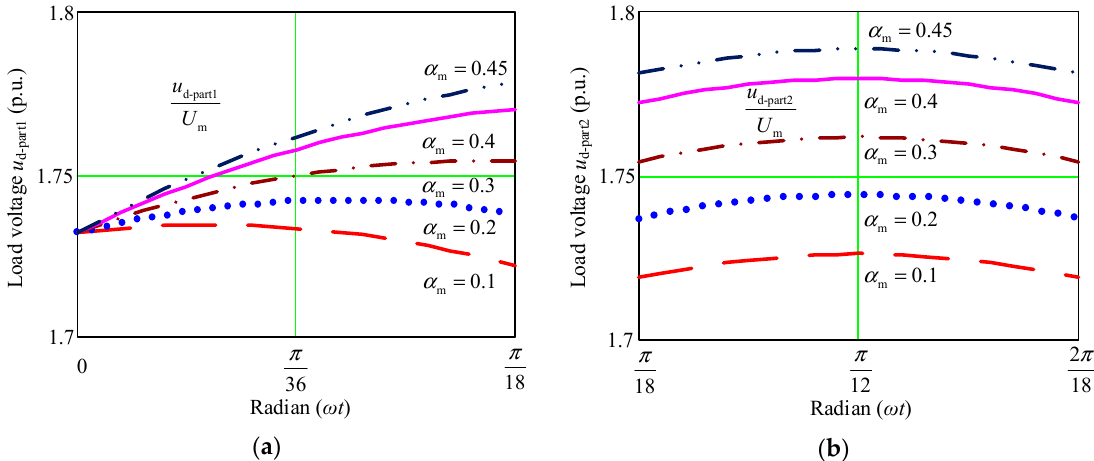
Figure 9. The first part and second part of load voltage waveform with different parameter α m . ( a ) The first part waveform u d-part1 ; ( b ) The second part waveform u d-part2 .